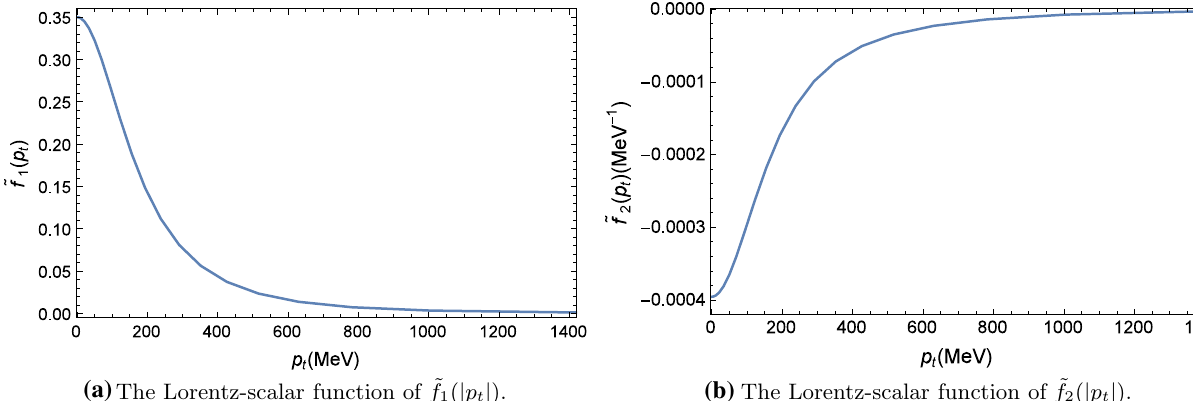
The Lorentz-scalar function of ˜ f 1 ( | p t | ). Fig. 2 Numerical result for the Bethe–Salpeter wave functions in the (cid:4) ¯ K system